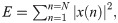
System (1) under stimulation.Biphasic stimulation with a 0.5 ms pulse width (total pulse duration is 1 ms) is applied to the system in type-1 bursting. Panels (a) and (b) show the energy map of the simulated LFP signal that is lower in the blue region than the yellow region (see the color bar on the right). The energy of the LFP signal was computed by using E=∑n=1n=N|x(n)|2, where n stands for the index of and N for the size of the discrete signal x(n). (a) Only the SOM+ interneurons receive the biphasic perturbation. (b) The pyramidal cell, SOM+ interneurons and PV+ interneurons receive the same biphasic perturbation. Panels (c), (d) and (e) show the time course of the marked stimulation on panels (a) and (b). (c) 15 Hz biphasic stimulation with 10 arb. unit amplitude is applied to the SOM+ interneurons (kSOM = 1, kP = kPV = 0). (d) 15 Hz biphasic stimulation with 10 arb. unit amplitude is homogenously applied to all subpopulations (kSOM = kP = kPV = 1). (e) 25 Hz biphasic stimulation with 10 arb. unit amplitude is homogenously applied to all subpopulations (kSOM = kP = kPV = 1).